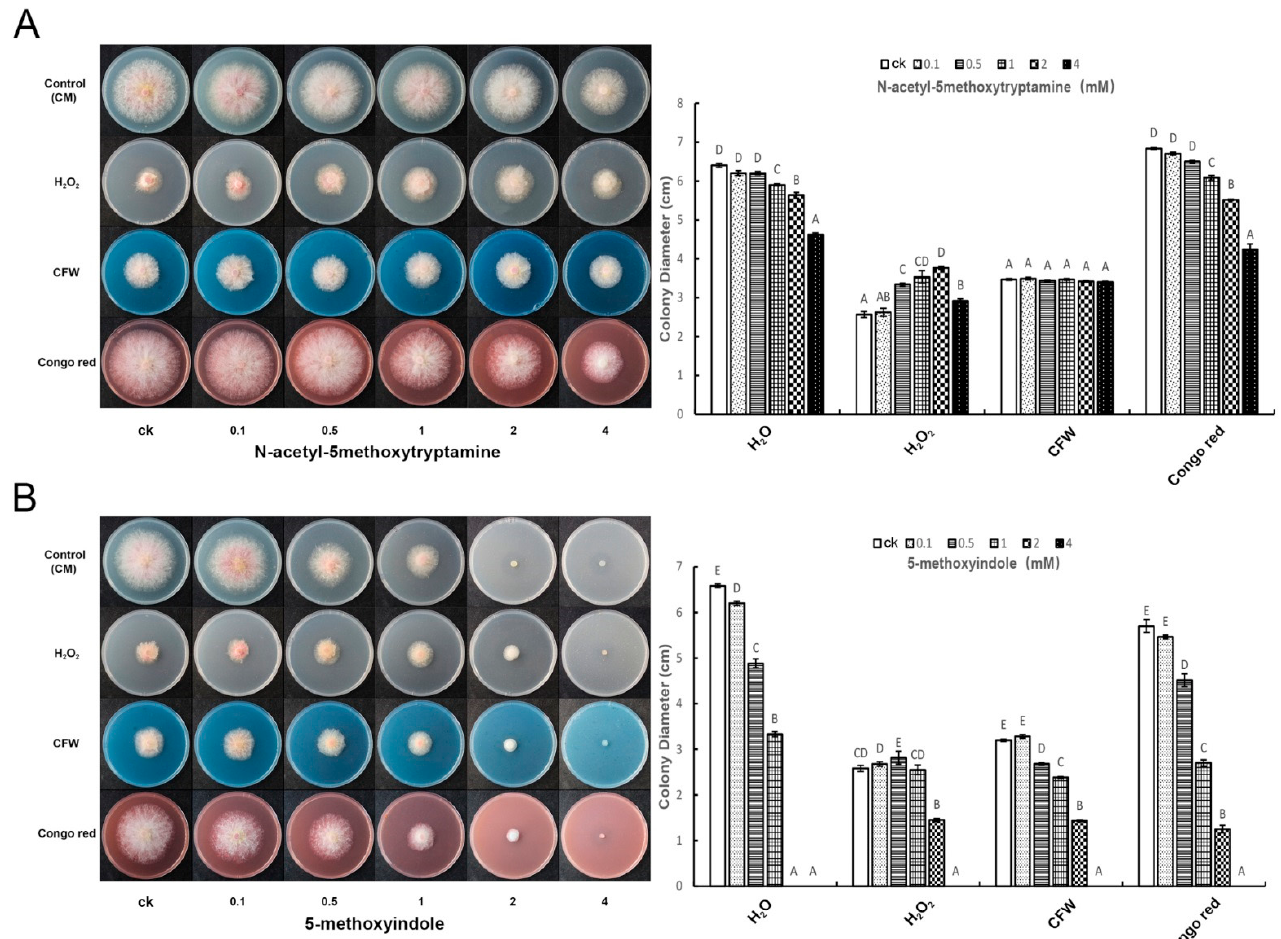
Figure 3. The functional analysis of pretreated melatonin and 5-methoxyindole with the fungus compound inhibitors (H 2 O 2 , CFW and Congo red) together. ( A ) The fungus F. graminearum PH-1 was grown in the medium CM after being treated with using melatonin and fungus compound inhibitors (H 2 O 2 , CFW, and Congo red) together for 3 days. ( B ) The fungus F. graminearum growth in the medium CM after treating 5-methoxyindole with the fungus compound inhibitors (H 2 O 2 , CFW, and Congo red) together for 3 days. The experiment was repeated independently three times, and 0.05% (vol/vol) methanol/water served as the ck. The error bars represent the mean standard deviation of each treatment repeated three times with three replicates. The letters above the columns indicate significant differences. The significant difference between the treatments was determined through Tukey’s HSD test at p ≤ 0.05.